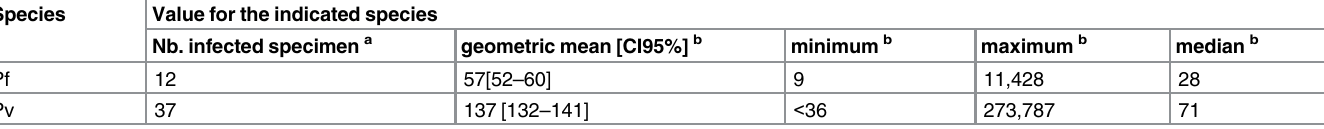
CI , con fi dence interval; Pf , Plasmodium falciparum ; Pv , Plasmodium vivax . a Nb. infected specimen: number of Anopheles naturally infected with Plasmodium . b Geometric mean, minimum, maximum and median of the sporozoite load in Anopheles naturally infected with Plasmodium , expressed in number of sporozoites per